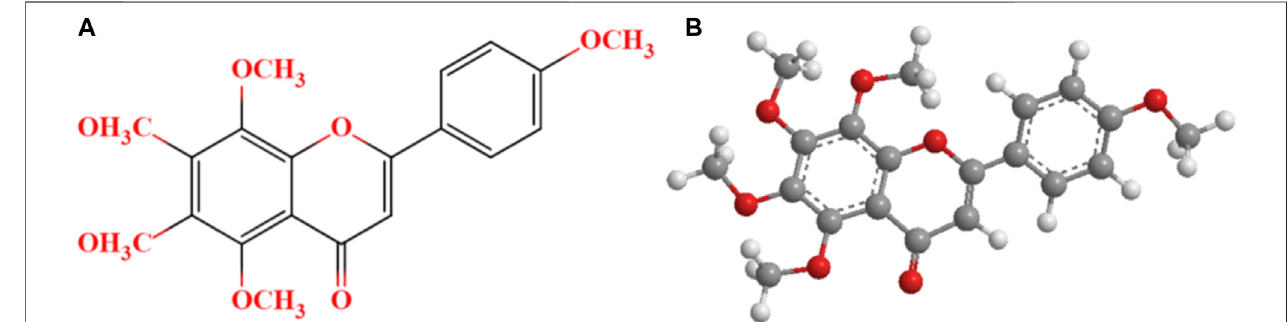
FIGURE 1 | The chemical structure (A) and 3D chemical structure (B) of tangeretin.